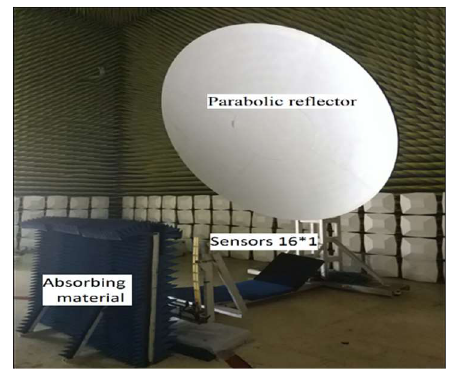
Figure 2. Parabolic reflector.